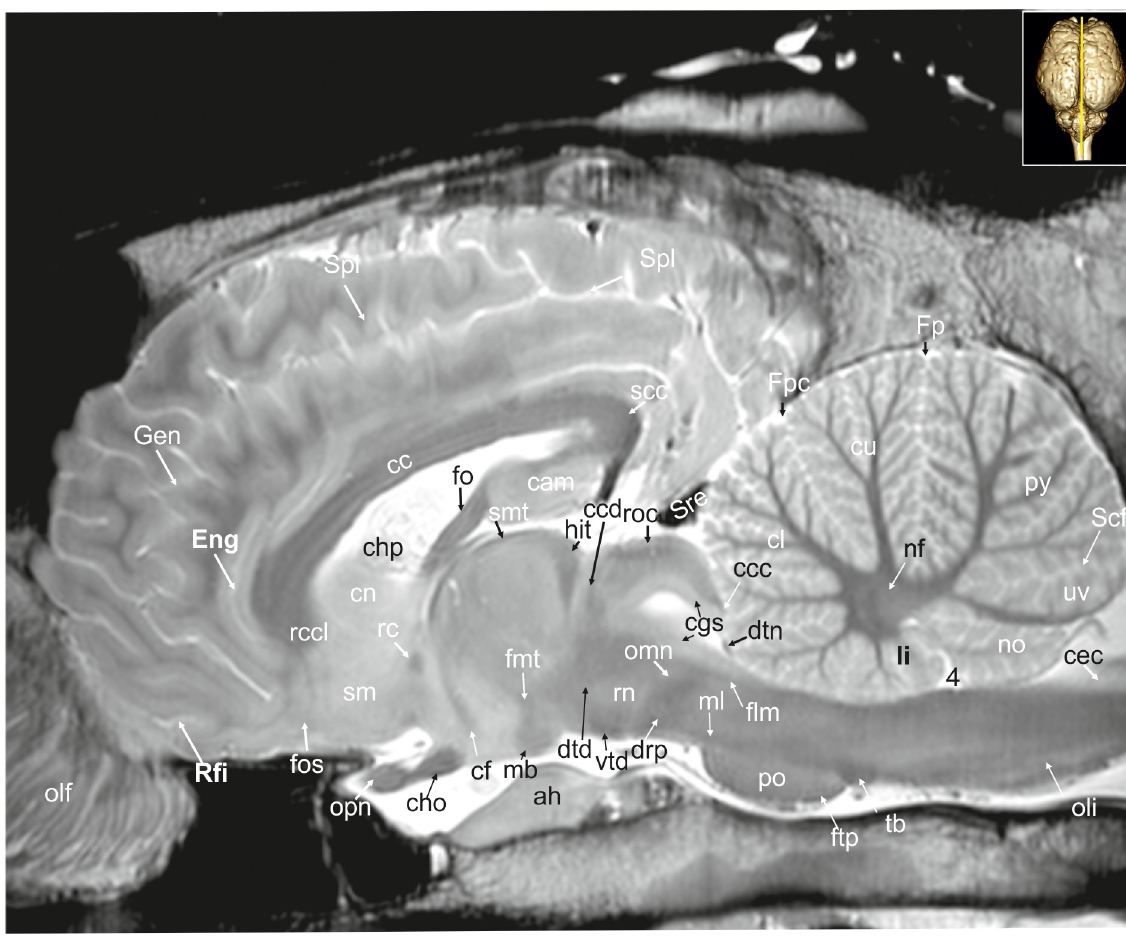
Fig 27. Parasagittal magnetic resonance image of the equine brain on the level of the columns of the fornix. cam: ammon’s horn, cc: corpus callosum, ccc: commissure of the caudal colliculus, ccd: caudal commissure, cec: central canal, cf: column of fornix, cgs: central grey substance, cho: optic chiasm, chp: choroid plexus, cl: central lobule, cn: caudate nucleus, cu: culmen, drp: decussation of the rostral cerebellar peduncles, dtd: dorsal tegmental decussation, dtn: decussation of trochlear nerve, Eng: endogenual sulcus, flm: medial longitudinal fasciculus, fmt: mammillo-thalamic fascicle, fo: fornix, Fp: primary fissure, Fpc: praeculminate fissure, ftp: transverse fibres of the pons, Gen: genual sulcus, hit: habenulo-interpeduncular tract, li: lingula of the vermis, mb: mamillary body, ml: medial lemniscus, nf: fastigial nucleus, no: nodulus of the vermis, olf: olfactory fibres, oli: olivary nucleus, omn: oculomotor nerve, opn: optic nerve, po: pons, py: pyramis of the vermis, rc: rostral commissure, rcc: radiation of corpus callosum, rccl: rostrum of the corpus callosum, Rfi: rhinal fissure, rn: red nucleus, roc: rostral colliculus, scc: splenium of corpus callosum, Scf: secondary fissure, sm: medial septal nuclei, smt: medullary stria of the thalamus, Spl: splenial sulcus, sre: straight sinus, tb: trapezoid body, uv: uvula of the vermis, vtd: ventral tegmental decussation, 4: fourth ventricle. characterized by a series of alternating grey matter and white matter layers, which is, however, not visible in our scans. Its dorso-lateral border is sharply defined by the hypointense optic radiation (efferents from lgb) and the ventro-lateral border defined by the optic tract (afferents to lgb). Beneath the lateral geniculate body and the pulvinar, a second slightly hyperintense ovoid swelling is located, the medial geniculate body (Corpus geniculatum mediale; Figs 8, 9, 11, 21, 29 and 31; S7 and S8 Figs: mgb) that is the thalamic relay nucleus for the auditory path- way. It receives direct input from the the brachium (connecting arm) of the caudal colliculi (Figs 10, 11, 21, 30 and 31; S9 and S10 Figs: bcc) that carries auditory afferent fibers via the lat- eral lemniscus (Lemniscus lateralis; Figs 11, 12, 19 and 29; S10 Fig: lal). Lateral and medial in this respect is referred to the conditions in humans, in the horse these geniculate bodies are stacked vertically [23].